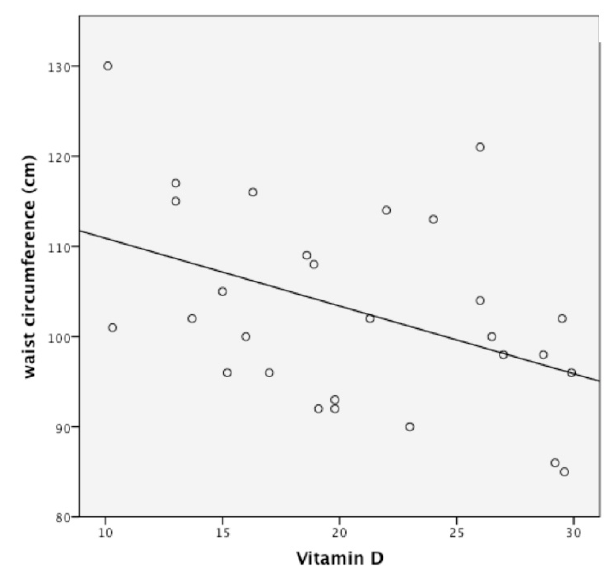
Figure 2. Linear correlation between serum 1,25(OH) 2 D (25(OH) D) and waist circumference at baseline; p < 0.05; R = 0.35. p < 0.05; R = 0.35.